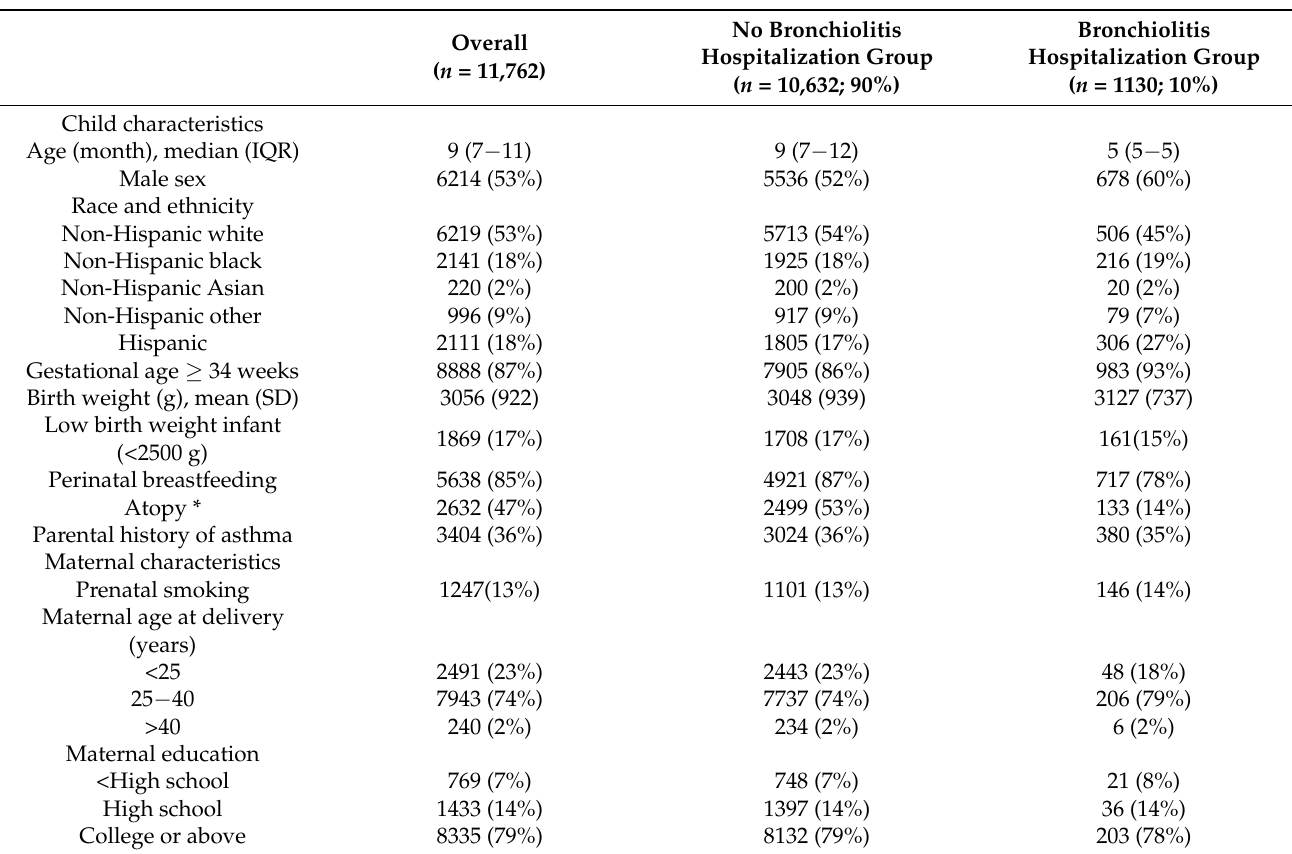
Bronchiolitis Hospitalization Group ( n = 1130;